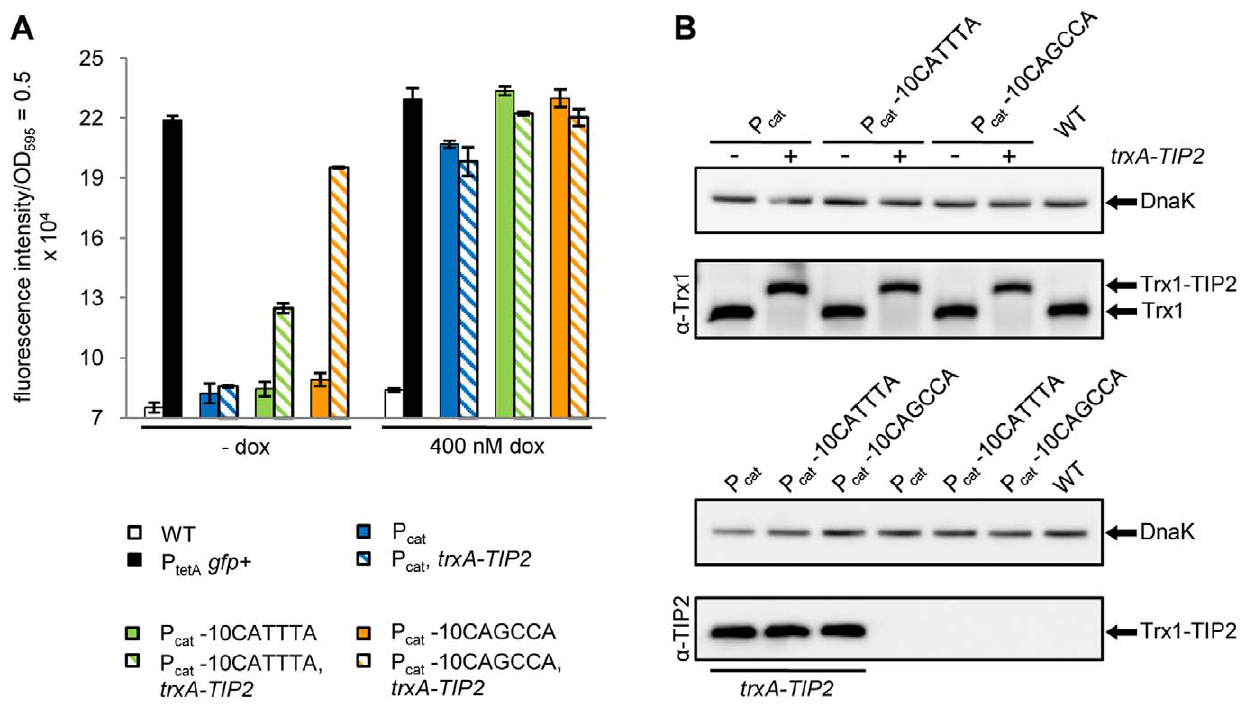
Figure 7. TetR induction by endogenous levels of a Trx1-TIP2 fusion in the promoter variants P cat , P cat -10CATTTA and P cat - 10CAGCCA. (A) GFP fluorescence measurement to examine TetR induction by a chromosomally encoded Trx1-TIP2 fusion protein. The three promoter variants and the control strains 2 Salmonella WT, the reporter strain lacking TetR (P tetA gfp + ) and the promoter variants without TIP2 in the genome 2 were incubated without and with 400 nM dox. The bars illustrate the fluorescence intensity which was normalized to a 1 ml culture with OD 595 =0.5. The data are a representative set from at least three independent measurements and display the mean 6 standard deviation. (B) Western blot for determining the steady-state levels of endogenous or TIP2-tagged Trx1 in the three promoter variants. The proteins were detected by polyclonal antibodies against either Trx1 (top) or TIP2 (bottom). With Salmonella WT serving as control, 10 m g crude lysate of each strain were loaded onto the gels. DnaK served as loading control and was detected with a monoclonal anti-DnaK